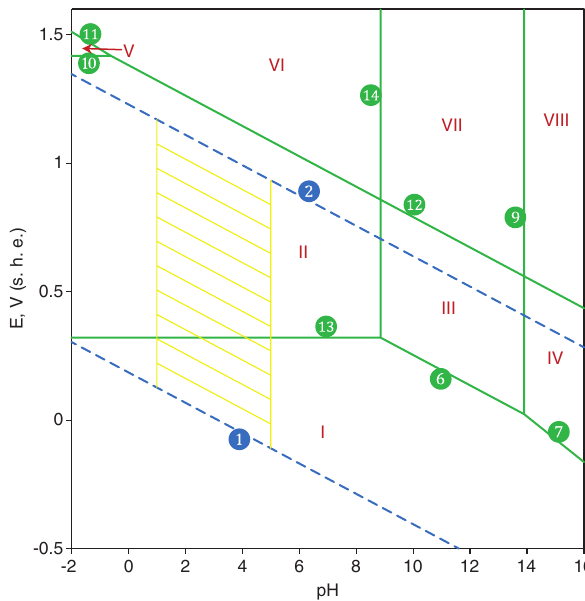
-CH l -H Og + system at 2